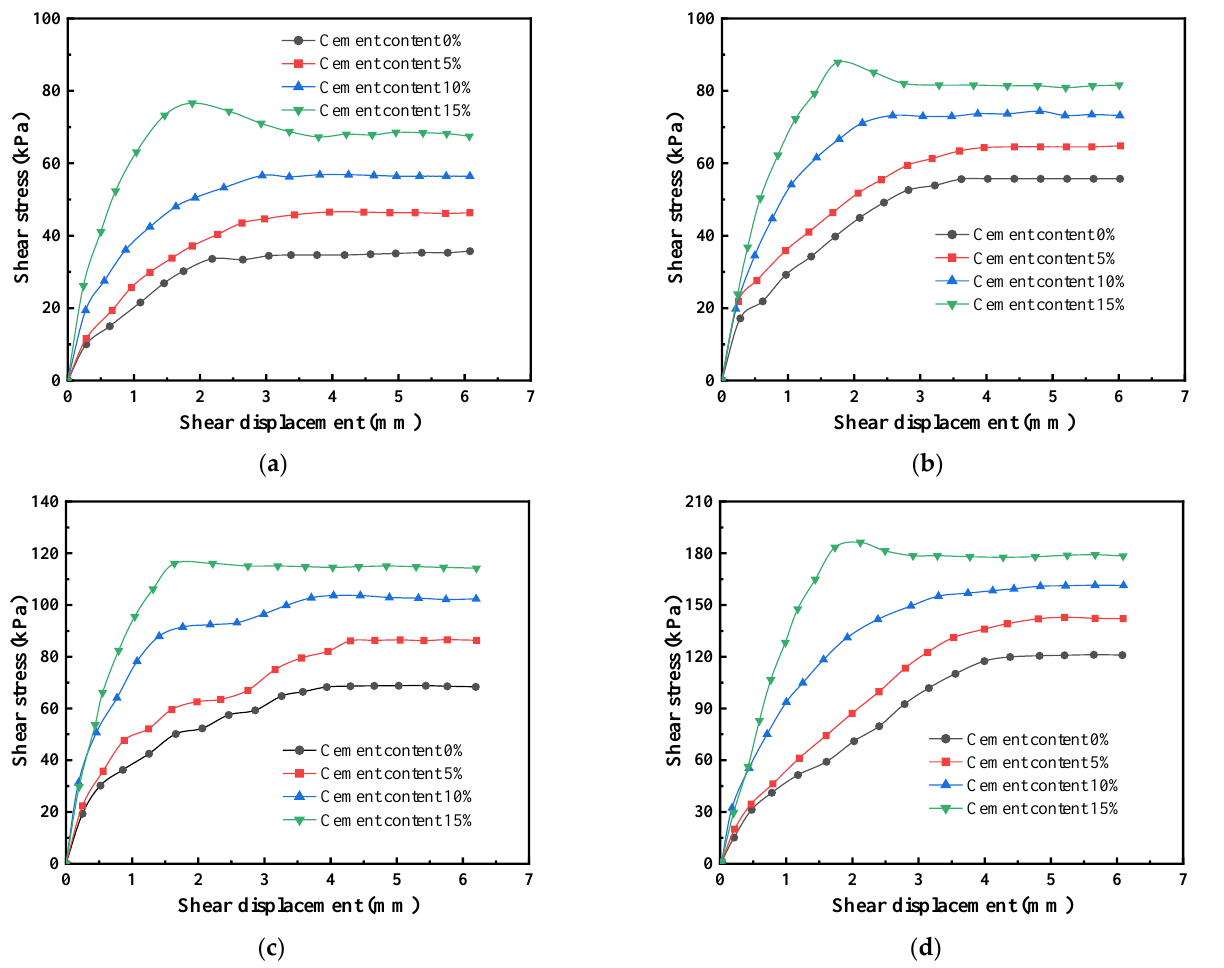
Figure 6. Curves of shear stress and shear displacement of silty clay. ( a ) σ = 50 kPa. ( b ) σ = 100 kPa. ( c ) σ = 200 kPa. ( d ) σ = 400 kPa.